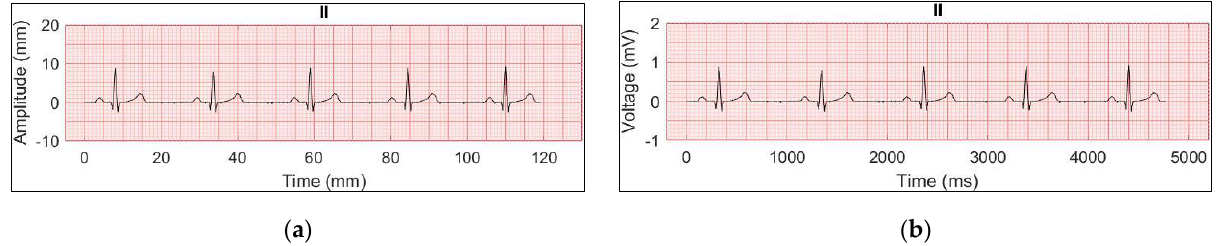
Figure 12. Reconstructed ECG signal (normal sinus rhythm, 60 bpm, II lead); ( a ) both axes are expressed in millimeters; ( b ) time is converted in milliseconds and voltage in millivolts (final version).